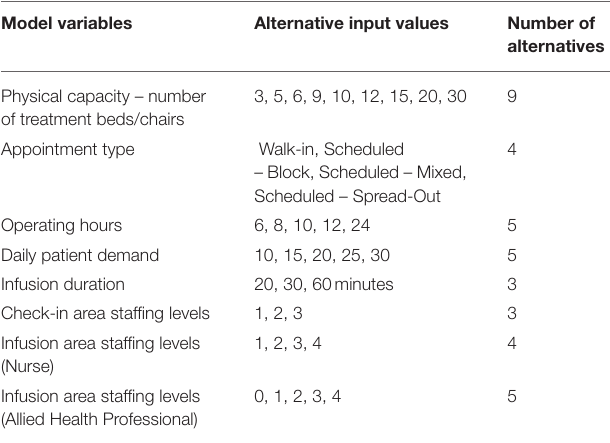
TABLE 3 | Model inputs for discrete event simulation model. Model